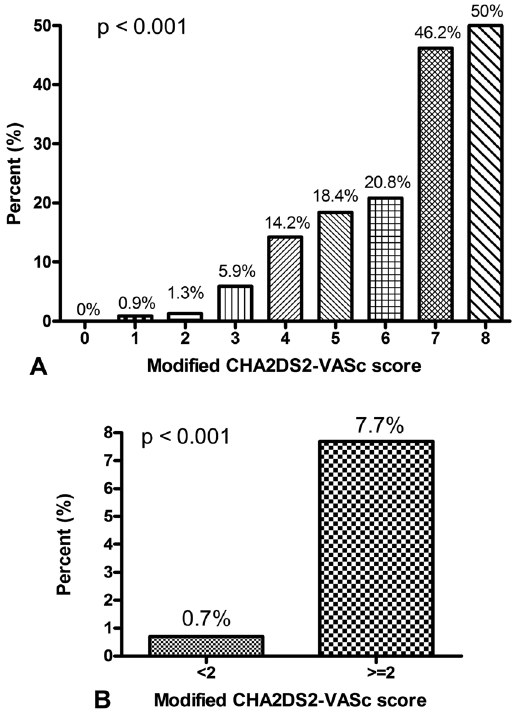
Figure 1. The percentage of ABI < 0.9 in patients with different modified CHA 2 DS 2 -VASc score ( A ) and in patients with modified CHA 2 DS 2 -VASc score < 2 and ≥ 2 ( B